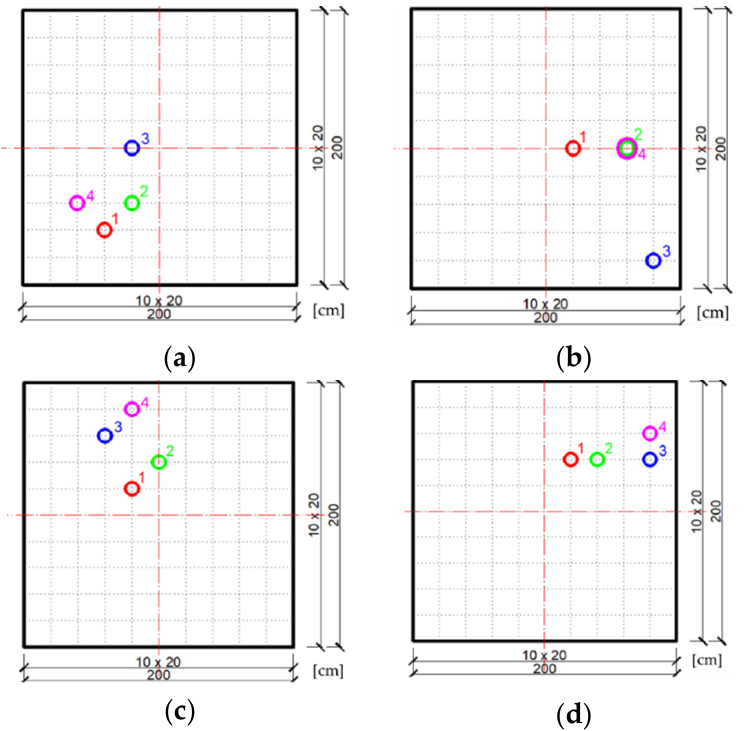
Figure 6. Initial swarm of particles (individual dampers) chosen randomly in individual plate neighborhoods: ( a ) Neighborhood 1; ( b ) Neighborhood 2; ( c ) Neighborhood 3; ( d ) Neighborhood